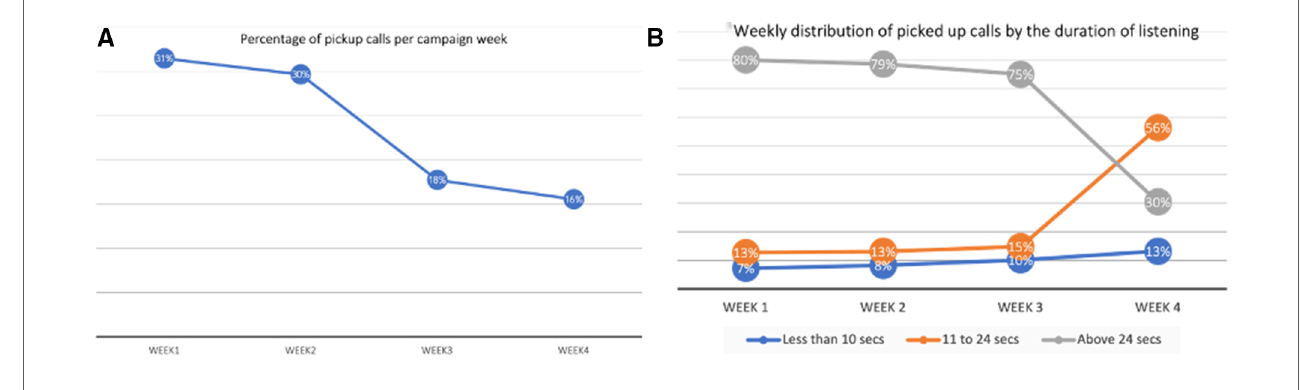
FIGURE 8 Percentage of call pickups ( A ) and Percentage duration of listening ( B